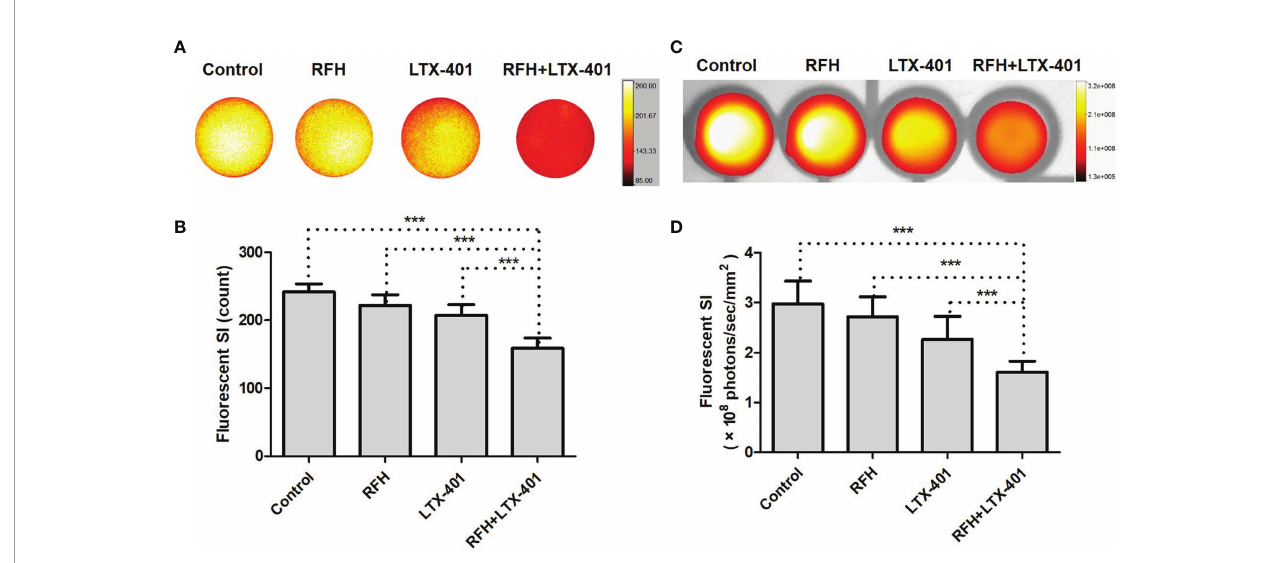
FIGURE 6 | In-vitro interventional optical images and optical/X-ray images of different cell groups. (A, B) In-vitro interventional optical images demonstrate a signi fi cant decrease of ICG signal intensity (SI) with the combination therapy of RFH + LTX-401, compared to other treatments (***= P <0.005). (C, D) Optical/X-ray images further con fi rm the same results, a signi fi cant decrease of ICG SI with the combination therapy of RFH + LTX-401, compared to other treatments (***= P <0.05).